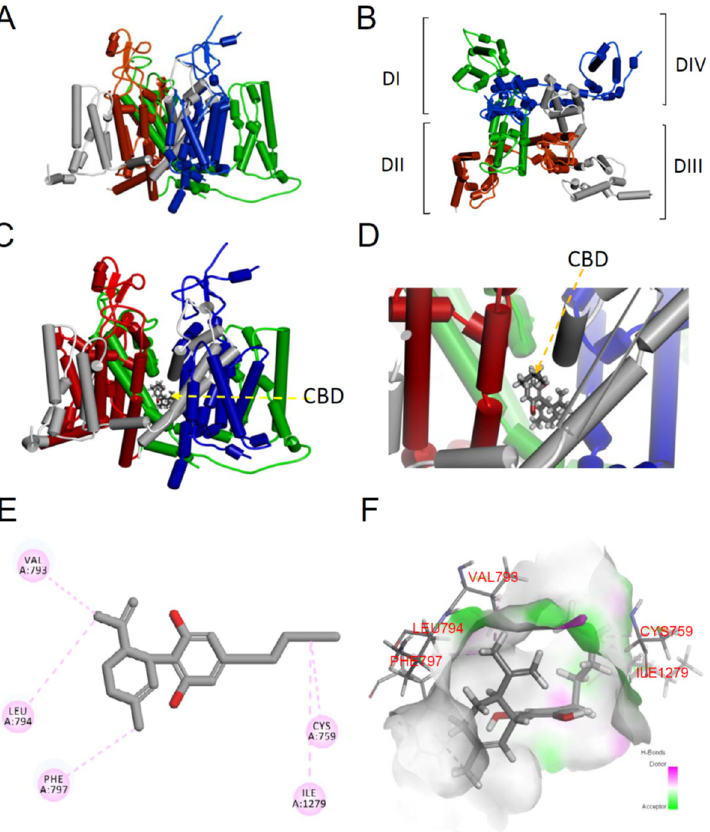
Figure 7. Homology modeling and docking interaction of the Na v 1.4 channel with cannabidiol. ( A ) The homology model was built based on the X-ray crystal structures of human Na v 1.4 channels (PDB: 6AGF) using the software Discovery Studio 2020 [37,38]. Four subunits of the Na v 1.4 channels homology modeling is shown. ( B ) A regional view of the extracellular side of the pore in the Na v 1.4 channel homology model, showing the transmembrane α -helix of the four domains. Domains I, II, III, and IV are colored in green, red, gray, and blue, respectively. ( C ) The 3D structure of the Na v 1.4 channel with the CBD complex using molecular docking. CBD is shown as a CPK model. ( D ) Close-up view of the Na v 1.4 channel with the CBD complex using molecular docking. ( E ) A 2D diagram showing the side chain of the Na v 1.4 channel associated with the CBD molecule. Note that Val793, Leu794, Phe797, Cys759, and Ile1279 of the Na v 1.4 channels are shown as the binding sites with CBD by the π alkyl interaction. ( F ) A 3D hydrogen bond surface plot at the binding site. The green color represents the conventional hydrogen bond, and the pink color represents the alkyl